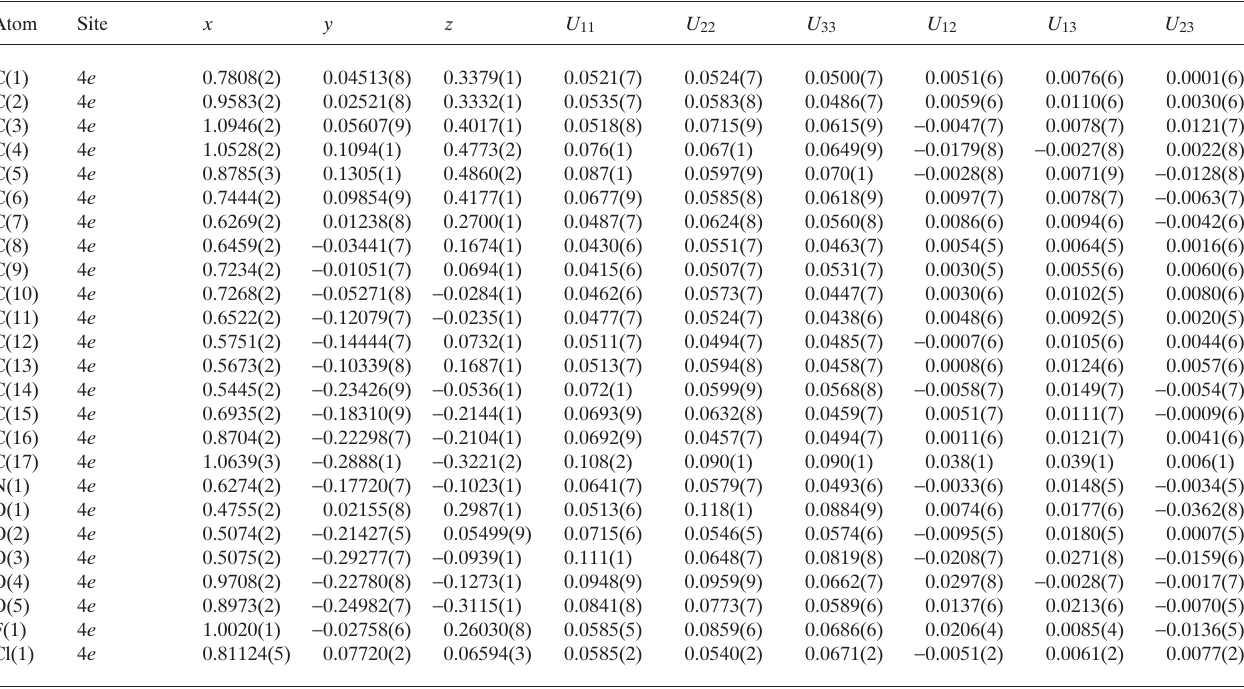
Table 3. Atomic coordinates and displacement parameters (in Å 2 )